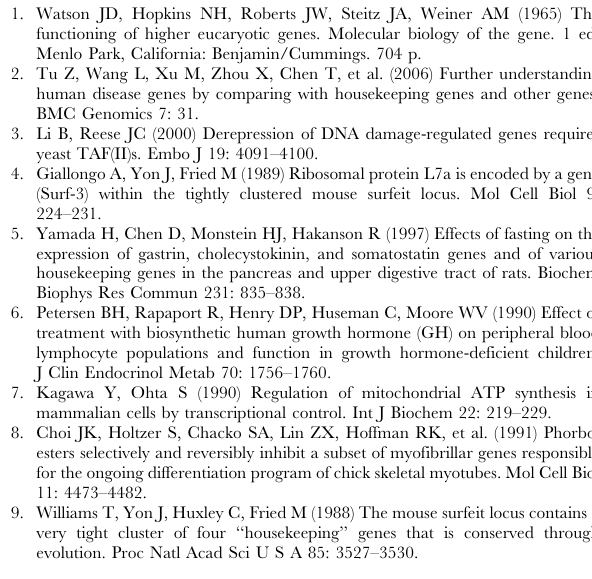
Figure S3 Kendall’s tau ( (cid:2) t tt 0 ) of expression rankings computed for various groupings of genes. Kendall’s tau for genes unique to the HK gene set curated by Zhu et al. [23] was higher than that for genes unique to an alternative set [37] (0.73 vs. 0.66), but both were considerably higher than that for a randomly selected set of MR genes (0.58) and Kendall’s tau was the highest (0.79) for genes common to both HK sets. Standard errors for these Kendall’s taus were all small, mostly less than 0.01. (PDF) Figure S4 Kendall’s tau ( (cid:2) t tt 0 ) for expression rankings as a function of four gene properties. The four properties examined are coding sequence (CDS) length (A), number of exons (B), average exon length (C), and GC content (D). The plots for the HK, MR, and TS sets are labeled. Pearson correlations (r HK , r MR , and r TS ) for each property are given at the bottom right of each panel. The three horizontal dashed lines represent the average Kendall’s tau computed for 100 genes chosen randomly from each of the three gene sets; from top to bottom, these correspond to the HK, MR, and TS sets. Note that, although the correlations for HK genes are high, a threshold cannot be established for any of the four properties to separate HK genes and NHK genes. (PDF) Table S1 The three Affymetrix oligonucleotide micro- array datasets and a Human BodyMap 2.0 RNAseq